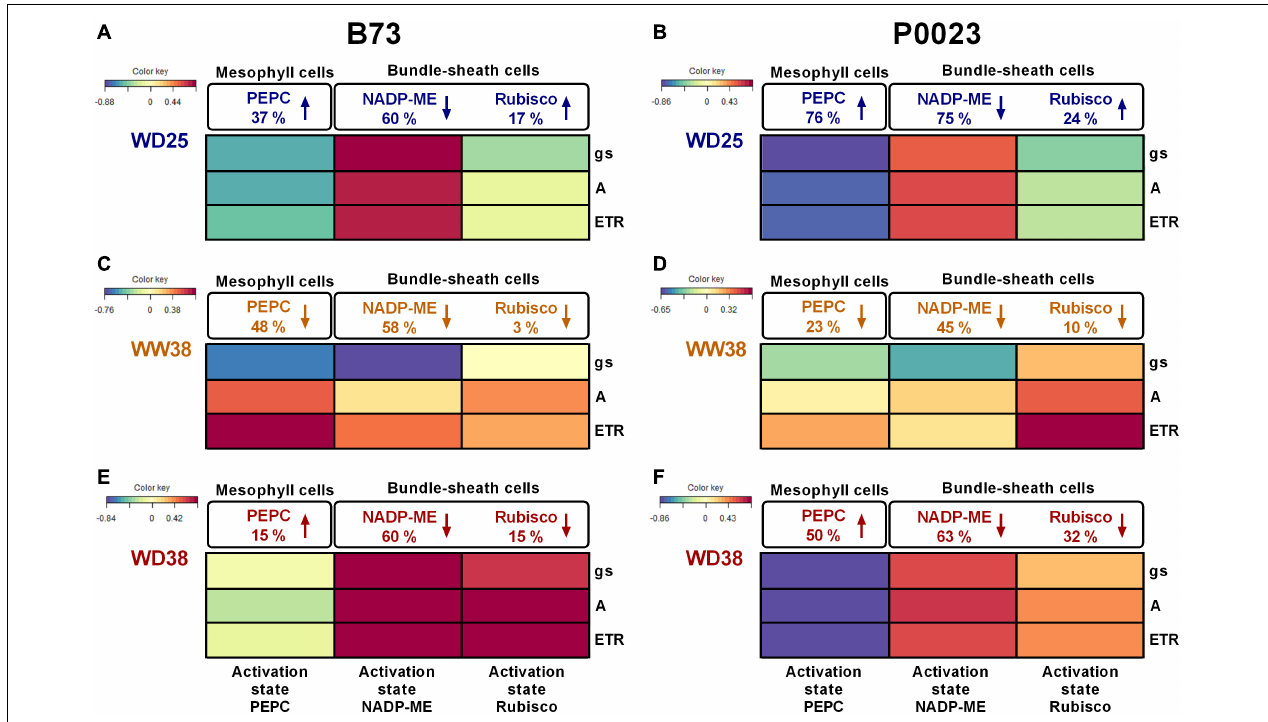
FIGURE 4 | The PEPC, NADP-ME, and Rubisco activation state of two maize genotypes (B73, P0023) grown under WW and WD conditions and acclimatized to 25 or 38 ◦ C. The heatmap represents the correlation between the activation state of key photosynthetic enzymes and steady-state chlorophyll a fluorescence or gas-exchange parameters of two maize genotypes (B73, P0023). The canonical correlations were determined according to the effect of (A,B) WD at 25 ◦ C (WD25), (C,D) high temperatures (WW at 38 ◦ C, WW38), and (E,F) WD combined with high temperatures (WD38), relative to control plants (WW25). The PEPC, NADP-ME, and Rubisco activities, gs, A and ETR were measured at the respective growth temperature (25 or 38 ◦ C), in fully expanded leaves and respective extracts from 4-week-old maize plants. Differences in the catalytic activity are represented as percentage changes relative to control (WW25) in extracts measured at the same temperature (25 ◦ C for WD25 and 38 ◦ C for WW38 and WD38, Supplementary Figures 1–3 ). The arrow direction indicates activity increase or decrease. The different colors denote positive (red) or negative (blue) correlations between variables ( n = 4–5 biological